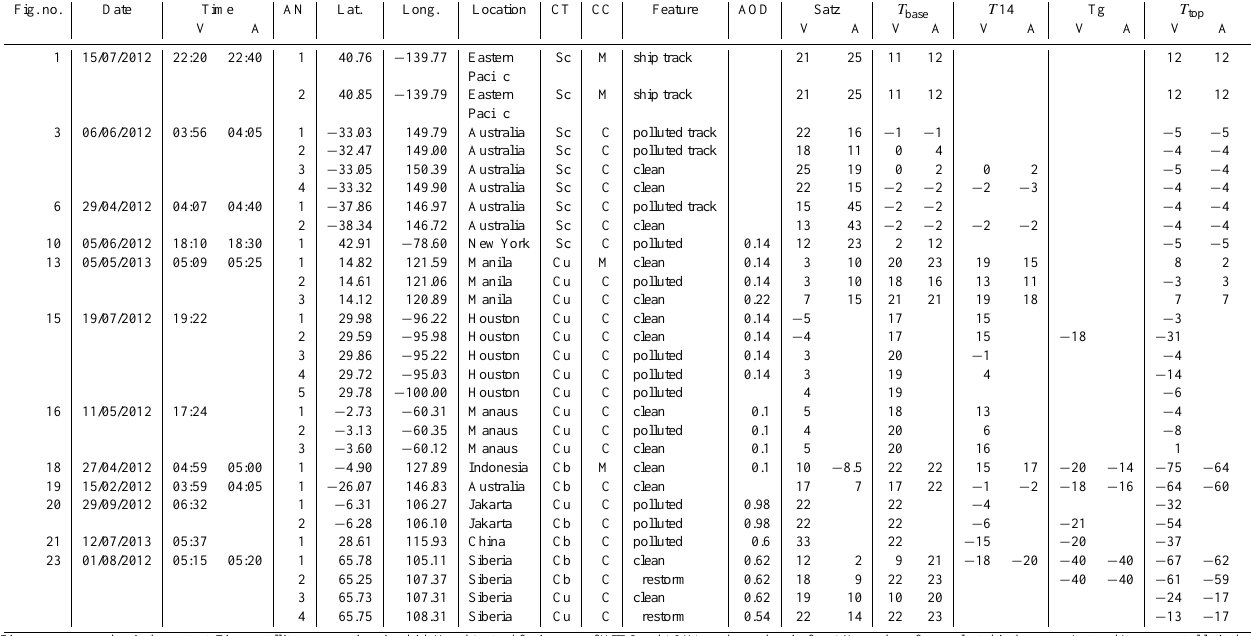
Fig.no.:figurenumberinthecontext;Time:satelliteoverpasstime,inwhichVandAstandforimagersofVIIRSandAQUA,andsamehereinafter;AN:numberofareaselectedinthefigure;Lat.andLong.:centrallatitudeand longitudeofselectedarea;Location:countryorcitywherecloudsarelocated;CT:typeofcloudclassification;Sc:stratocumulus;Cu:cumulus;Cb:cumulonimbus;CC:generalcloudpropertiesinwhichMandCstandsfor maritimeorcontinentalcloud,respectively;Feature:cloudfeatureorimpactbypollutionorcleancloudforcomparingwiththepollutedcloud;AOD:aerosolopticaldepthfromMODISproduct;Satz:satellitezenithangle; T base :temperatureofcloudbase; T 14:temperatureof r e reaching14µm,initiationofprecipitation; T top :temperatureofcloudtop;Tgistheglaciationtemperature.